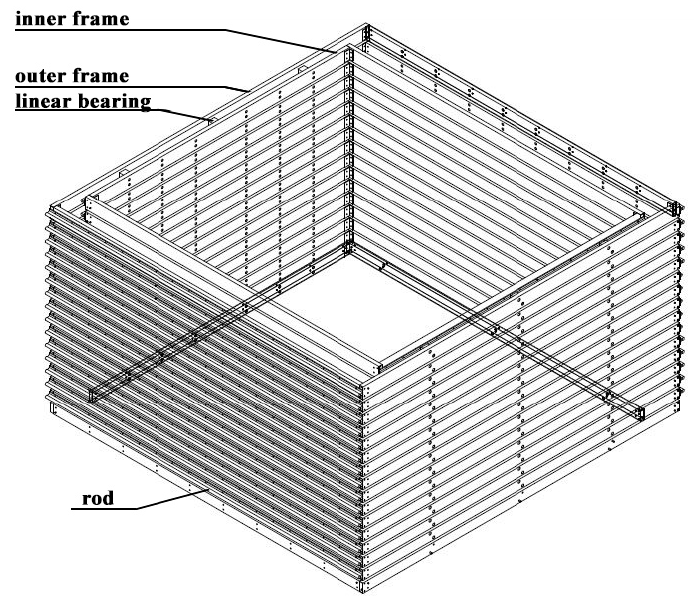
Figure 18. Isometric view of the inner and outer frames.